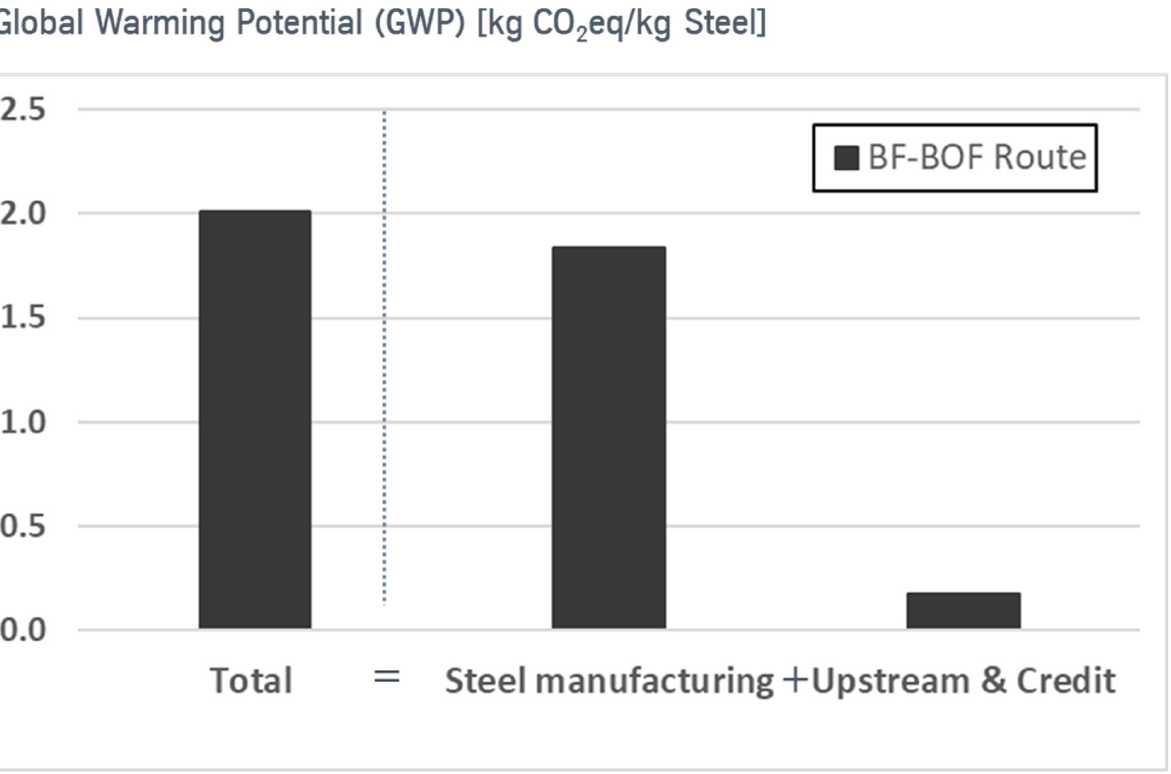
Figure 1. Global warming potential (GWP) of steel produced via the blast furnace–basic oxygen furnace (BF-BOF) route. Total GWP according to GaBi database 2021.1.